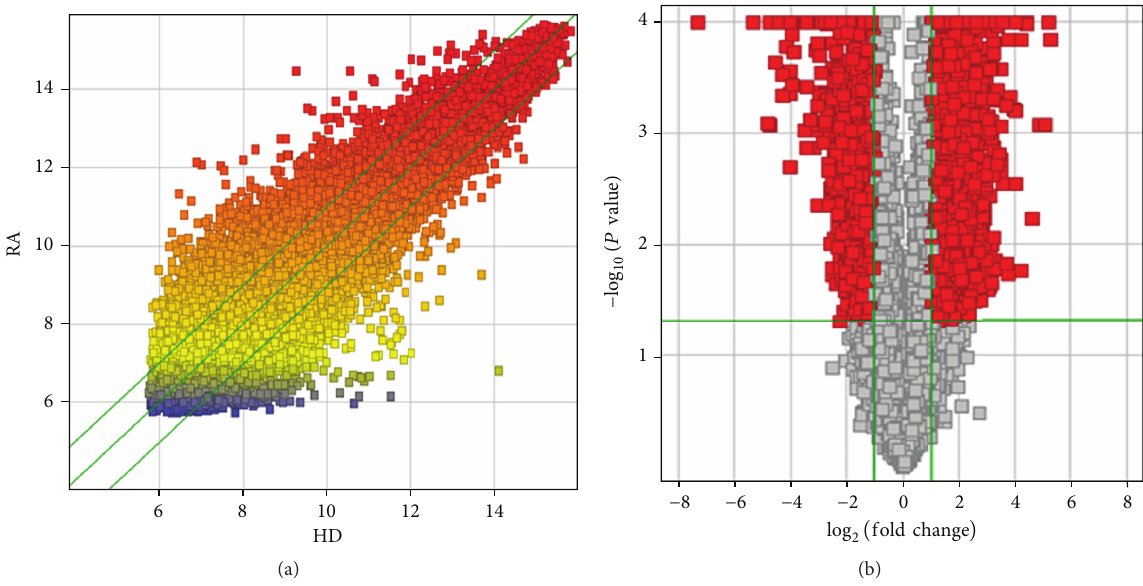
Figure 3: Scatter plot and volcano plots of differentially expressed genes. (a) Differentially expressed genes of SMSCs from both RA patients and HDs are shown in the scatter plot; each value represents a normalized signal value from each gene (log 2 scale). Fold-change lines are shown as green lines in the scatter plot, and gene fold-changes ≥ 2.0 between the RA and HD groups are shown above the top green line and below the bottom green line. (b) The volcano plots were constructed using fold-change values (log 2 scale) and 𝑃 values ( − log 10 scale). The vertical lines correspond to 2.0-fold change up and down and the horizontal line represents a 𝑃 value of 0.05. The red point in the plot represents the significantly differentially expressed